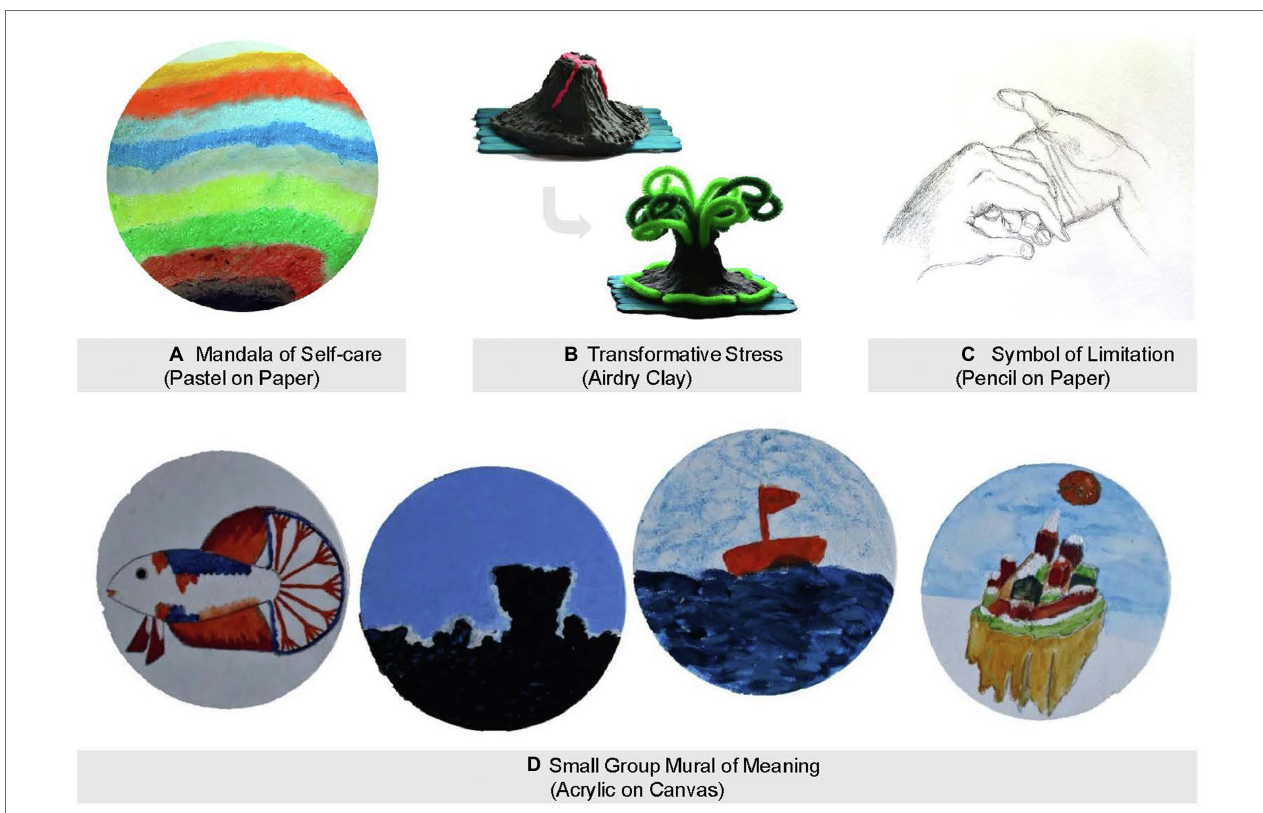
FIGURE 2 | (A) Mandala of self-care (Pastel on paper). (B) Transformative stress (Airdry clay). (C) Symbols of limitation (Pencil on paper). (D) Small group mural of meaning (Acrylic on